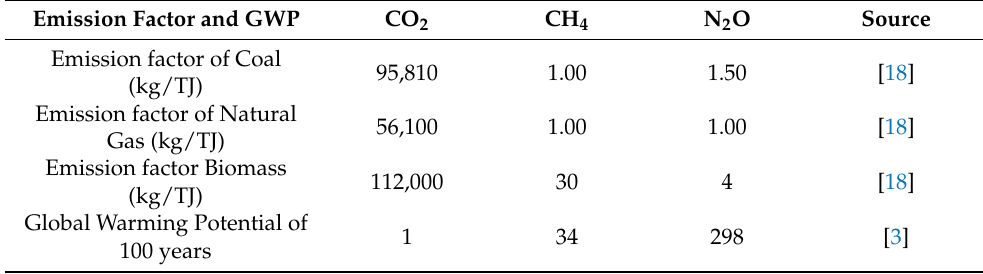
Table 4. Emission factors and global warming potentials